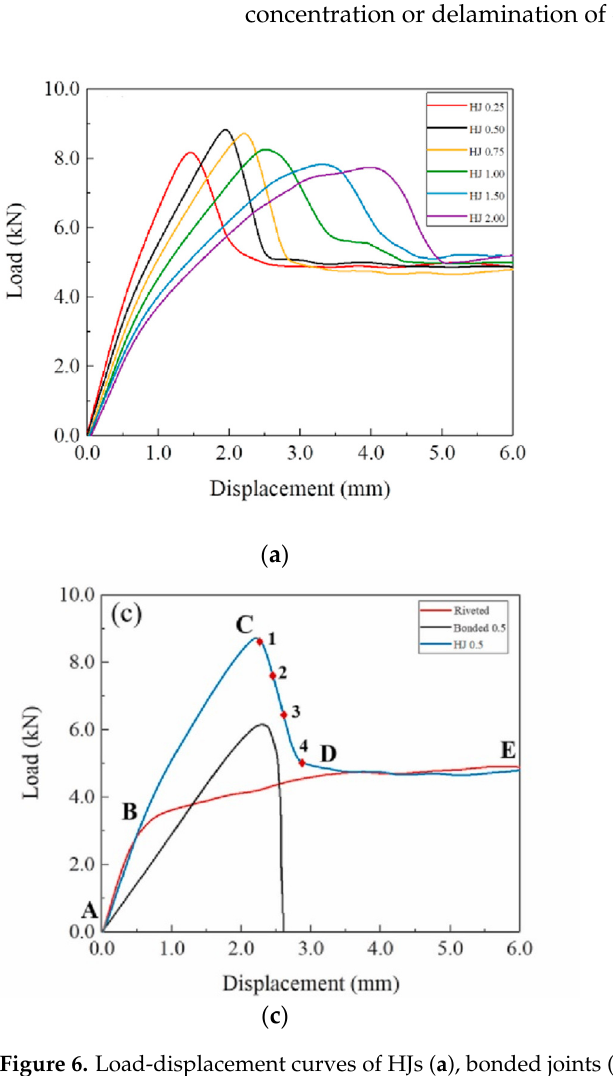
15% error level compared with experimental curves. Simplified finite element models